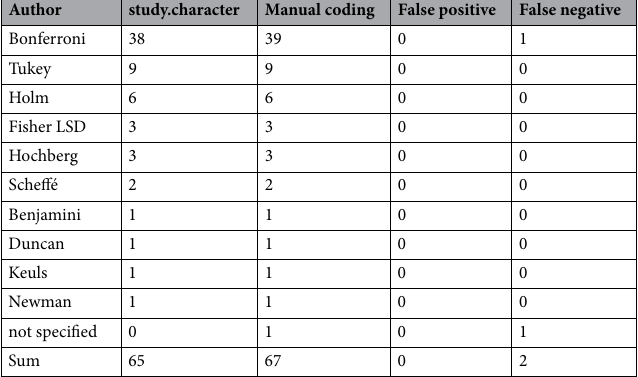
Table 7. Absolute frequencies of authors of multiple test correction procedures.